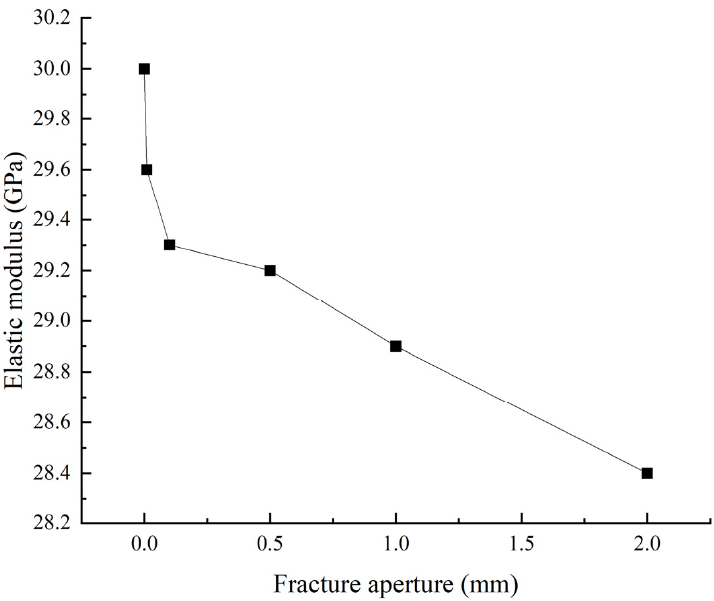
Figure 14. The elastic modulus decreases abruptly with the addition of fractures and becomes stable when the fracture aperture is large enough.